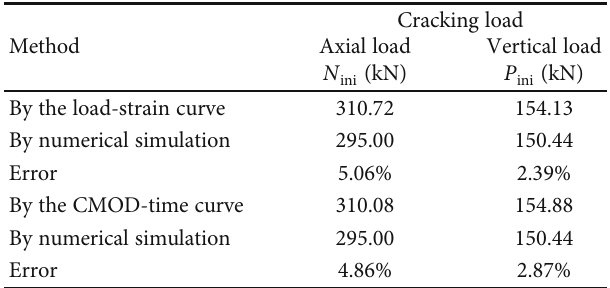
Figure 13: Crack growth path: (a) experimental results [13]; (b) Numerical results. Table 1: Cracking load of the lining segment by experiment and numerical